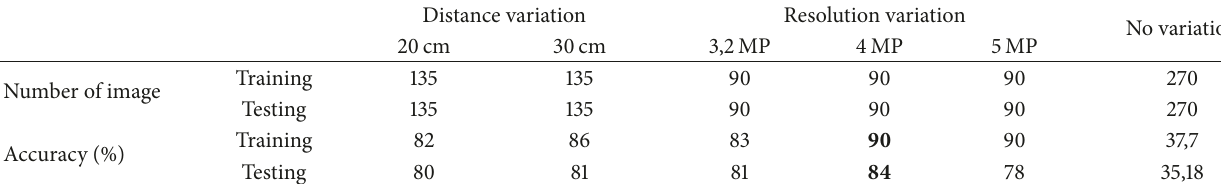
Table 5: Overall results from both training and testing processes.